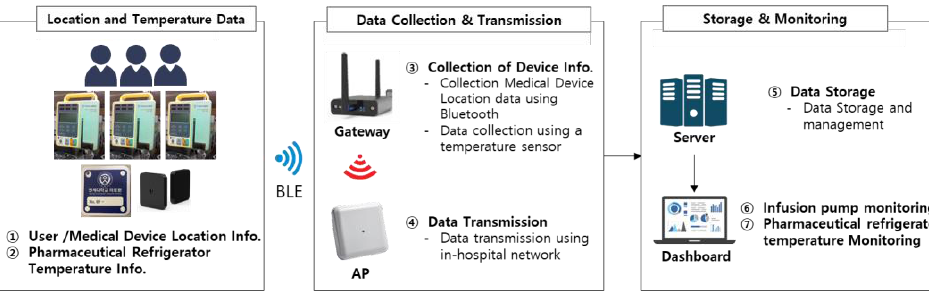
Figure 7. Hospital Monitoring System.